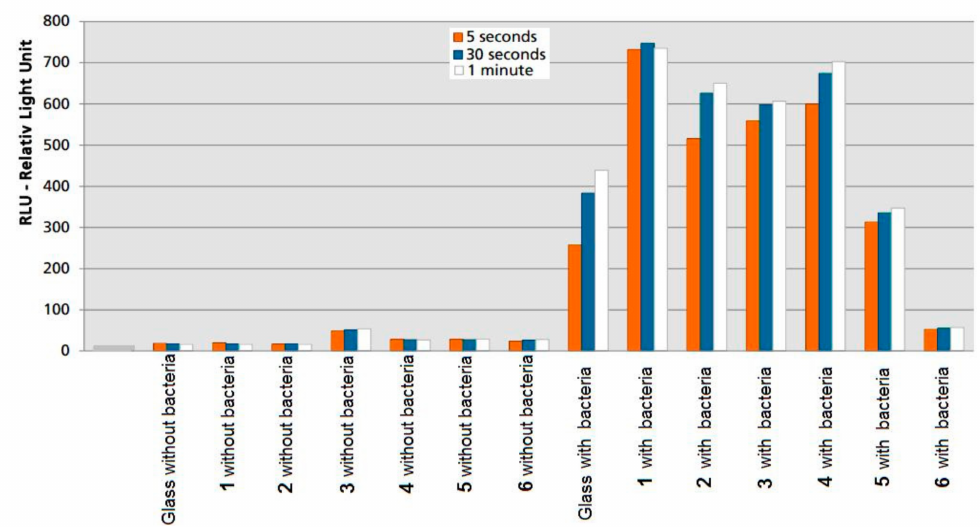
Figure 4. ATP (Adenosine thriphosphate) luminescence (in absence of biofilm and with biofilm formed after a 1 h incubation of 4.107 cfu/mL C. marina ) on non-covered glass and glass covered with a coating containing: (1) 6 wt % conventional cross-linker, ES 40 (control); (2) 4 wt % ES40 + 2 wt % PEG-silane; (3) 6 wt % ES40 + 2 wt % PEG-silane; (4) 4 wt % ES40 + 2 wt % PEG-silane + 0.5 wt % NIS; (5) 4 wt % ES40 + 2 wt % PEG-silane + 2.0 wt % AO; (6) 4 wt % ES40 + 2 wt % PEG-silane + 0.5 wt % NIS + 1.5 wt %